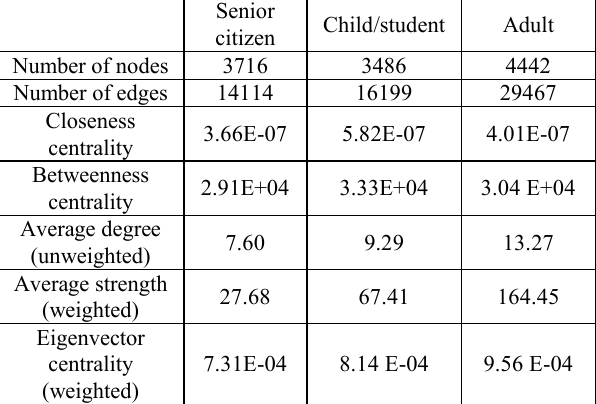
(b) Child/student: West Region (a) Senior: Central Region and North-East